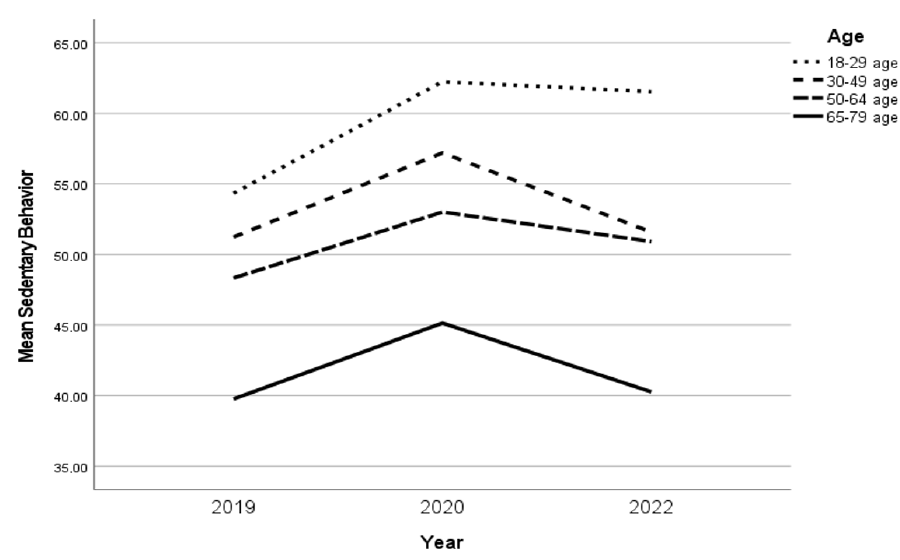
Figure 4. The changes in SB in the age groups over time.